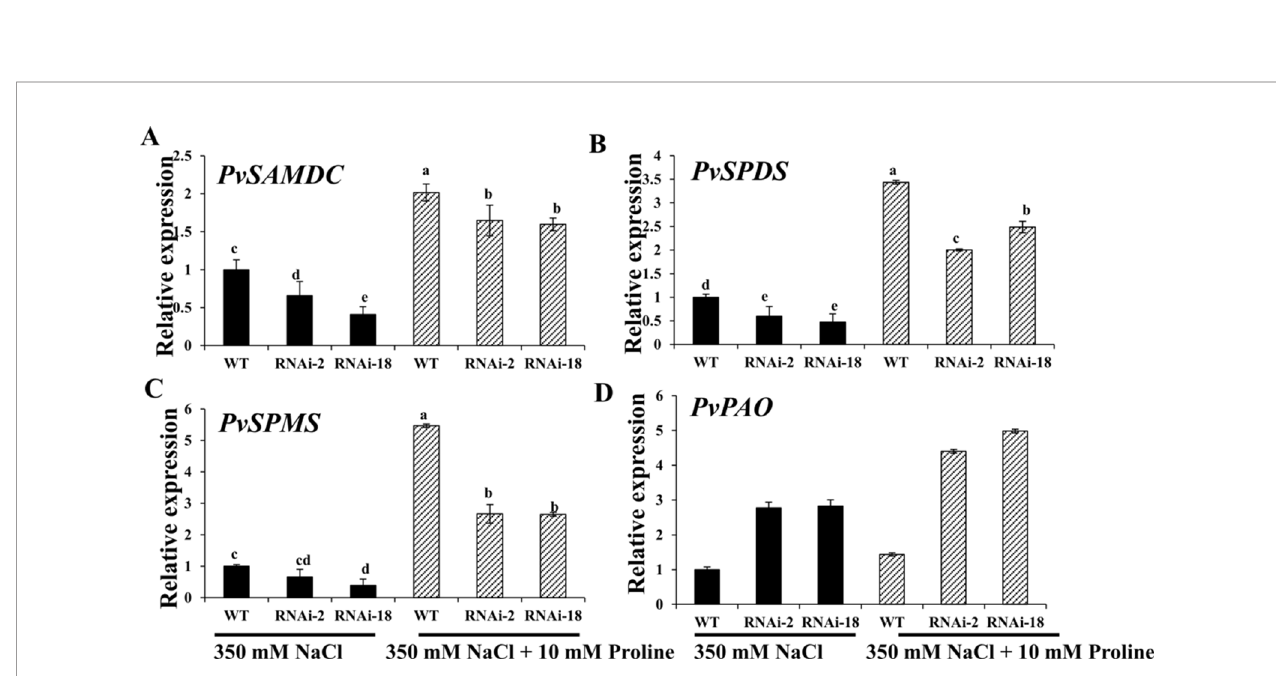
FIGURE 8 | Exogenous proline can largely improve transcript levels of the genes involved in polyamine synthesis (A – C) and catabolism (D) in PvP5CS RNAi transgenic plants under 350 mM NaCl salt stress. Switchgrass UBQ1 was used as the reference for normalization. Data are mean values of three biological repeat, and signi fi cance of treatments was tested at the P < 0.05 level (one way ANOVA, Dunnett's